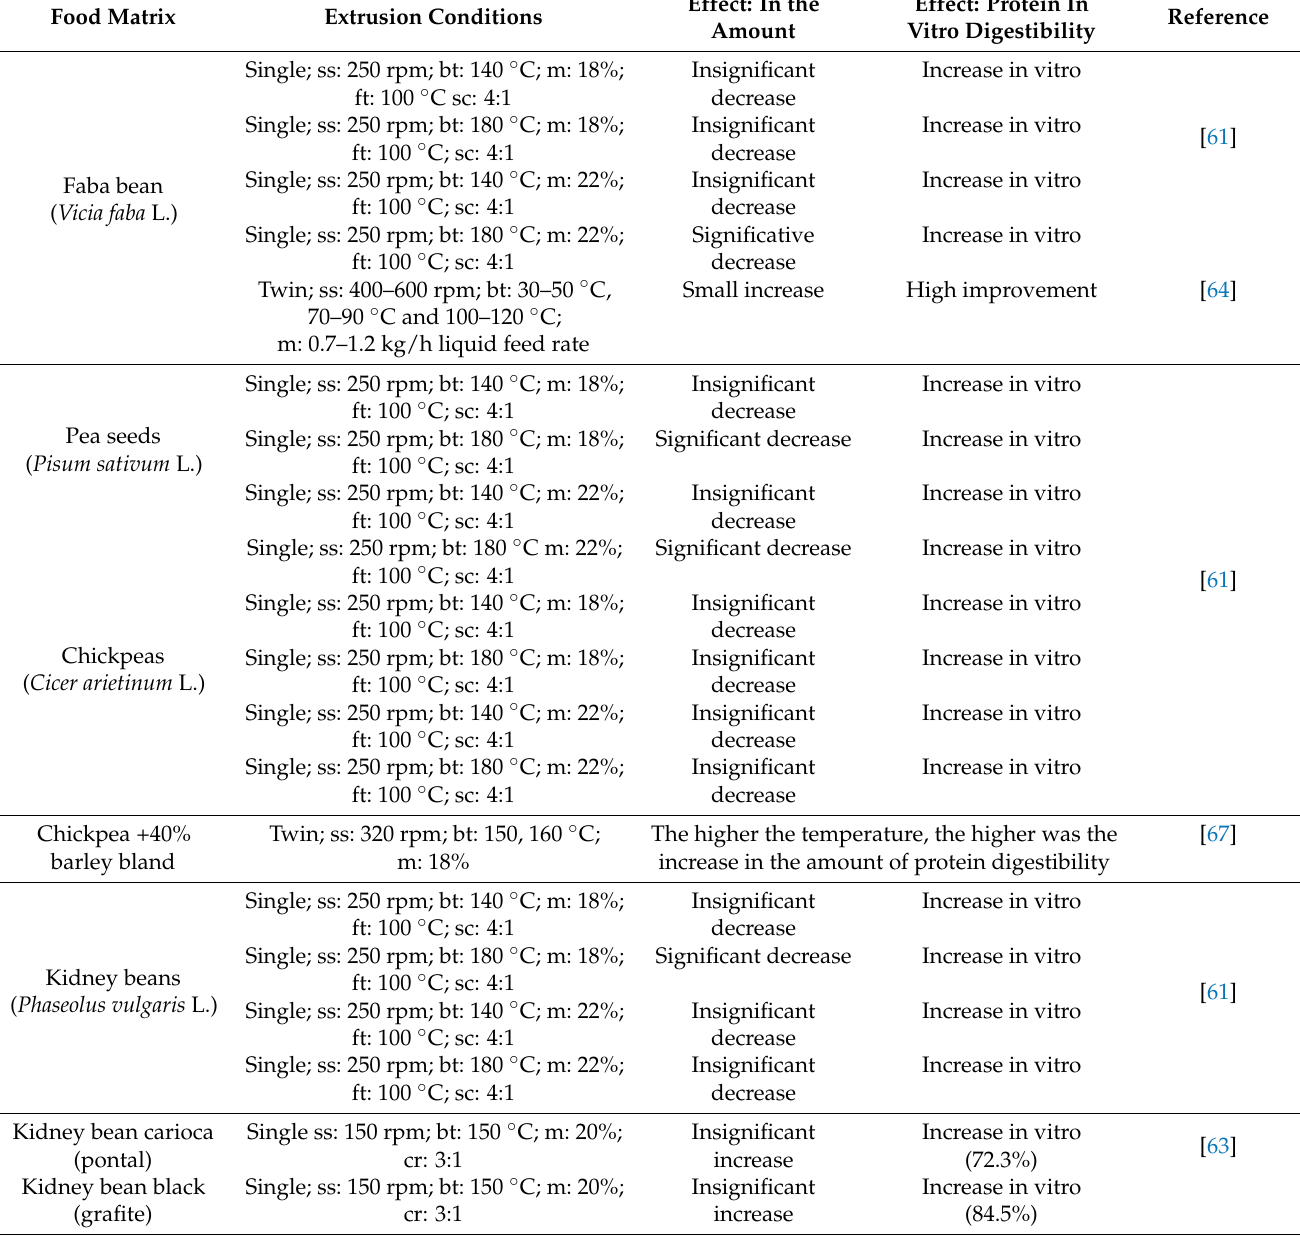
Table 1. Effect of different extrusion processing conditions on the protein content of pulses and pulse-based extrudates. Food Matrix Extrusion Conditions